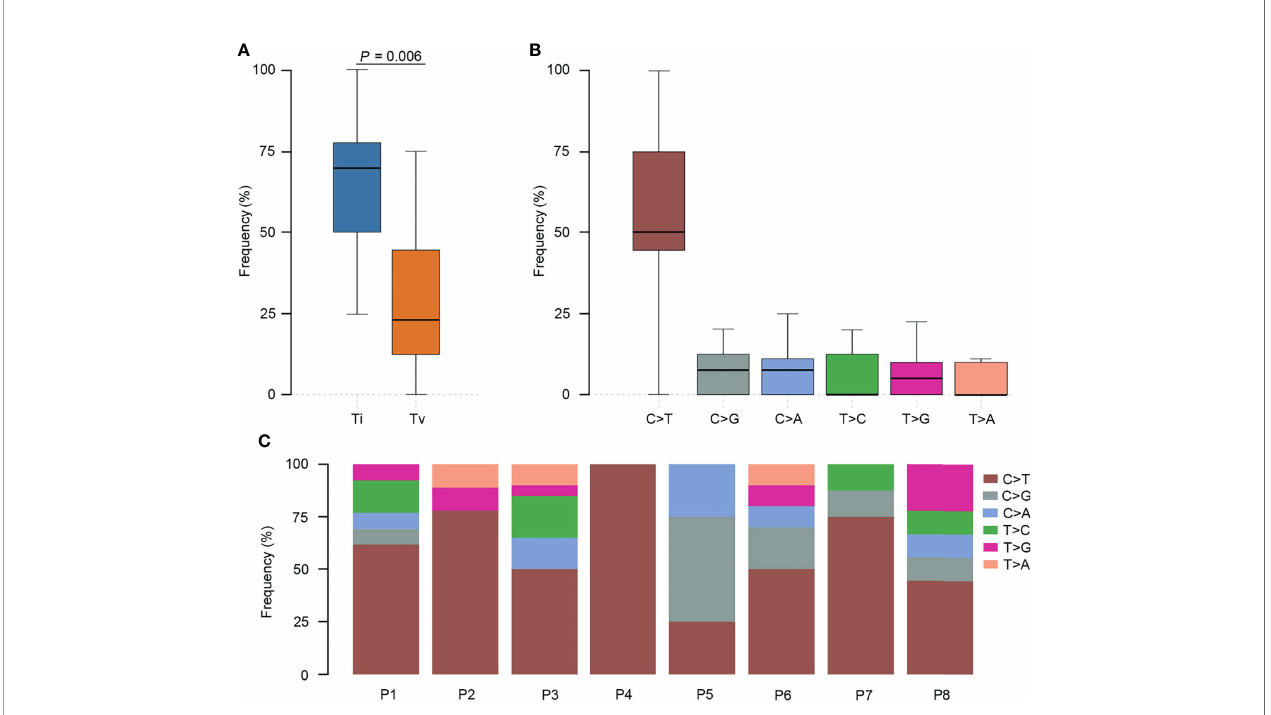
FIGURE 2 | Transition (Ti) and transversion (Tv) pro fi les for SCRC. (A) Comparison between Ti and Tv ratios in SCRC. (B) The bar plot shows each type of Ti or Tv. (C) The box plot exhibits the ratio of each type of Ti or Tv for each